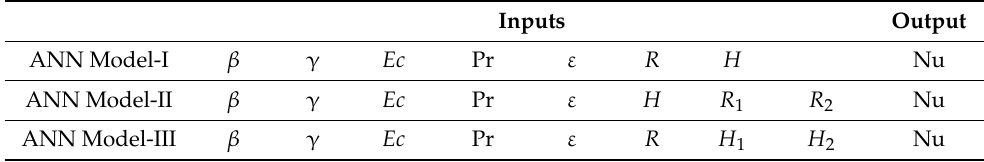
Figure 1. The symbolic architecture of an MLP network model. Table 1. Output and input values of three different ANN models.